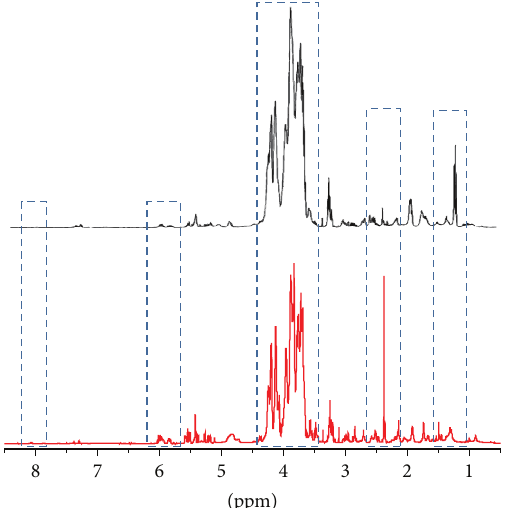
Figure 9: The comparison between the HR-MAS NMR spectra, of two different experiments on two red garlic samples: the red garlic of Nubia (red line, measured by us with a 700 MHz spectrometer) and the red garlic of Sulmona (black line, measured by Ritota et al. [16] with a 400 MHz spectrometer). The highlighted regions represent the most important similarities and